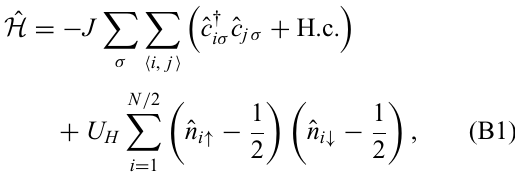
ˆ H ˆ H ˆ H ˆ H A , B , C , and D in the fermion ˆ H ˆ H ˆ H A , B , and C correspond to the ˆ H D corresponds to the interaction